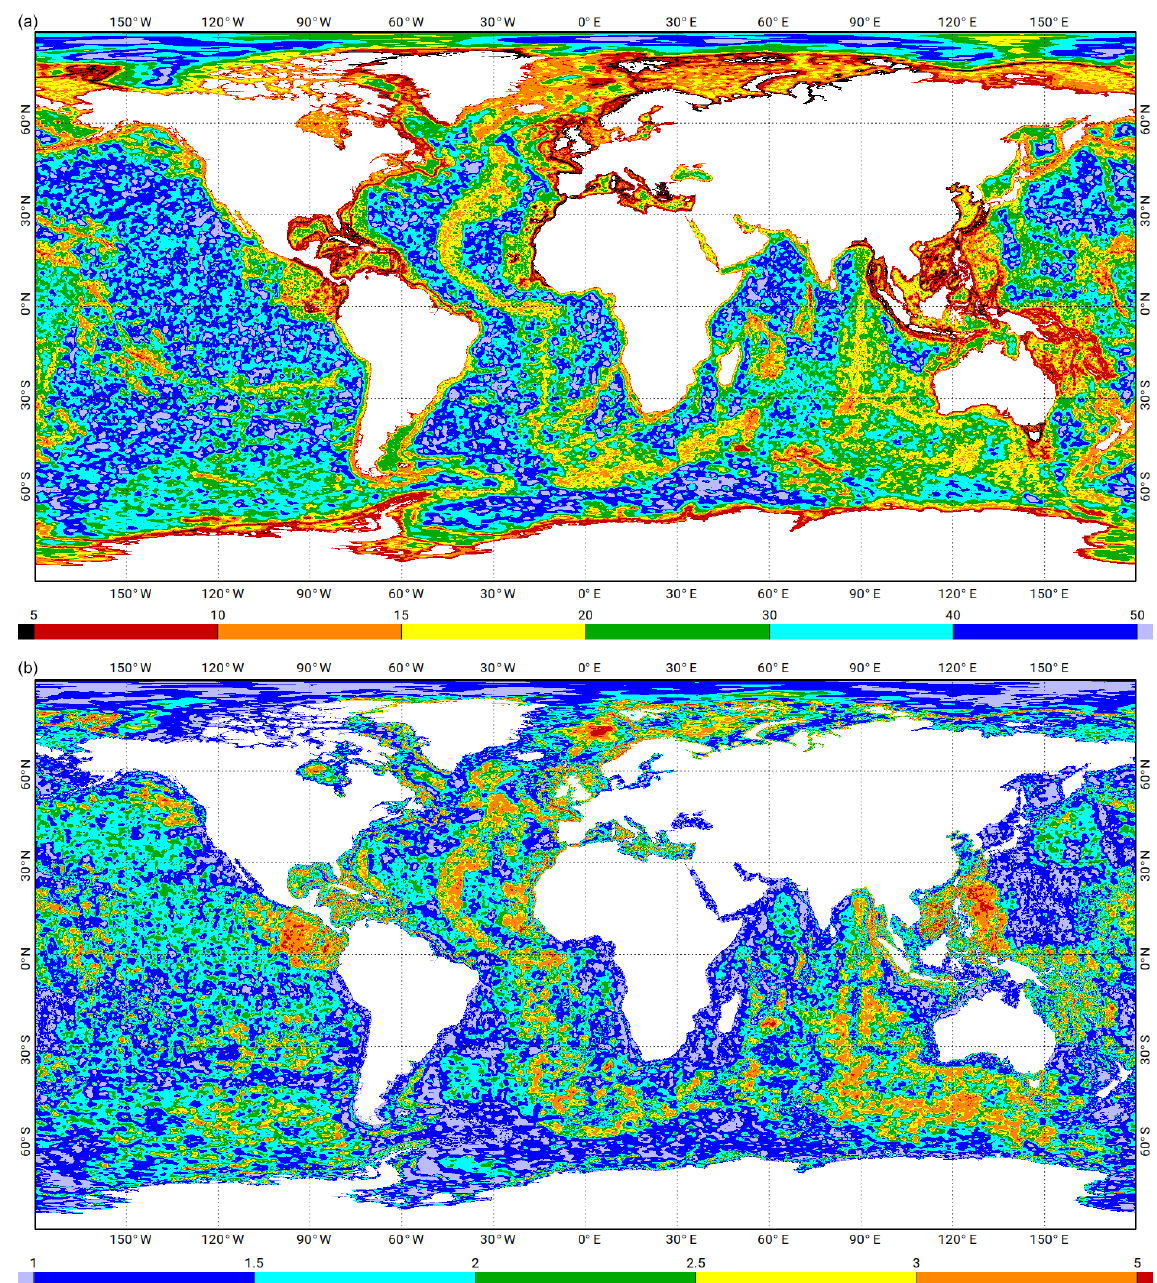
Figure 1. Element-wise resolution (in km) of the FES2014 unstructured grids (a) and the FES2014 resolution divided by FES2004 resolution ratio (b) . Resolution increase has been mostly focused on ocean ridges, shelves, and shores (wherever reasonably accurate bathymetry was made available to the project). The numerical resolution of the frequency-domain solutions is half the element-wise resolution due to second- order basis functions (Lagrange